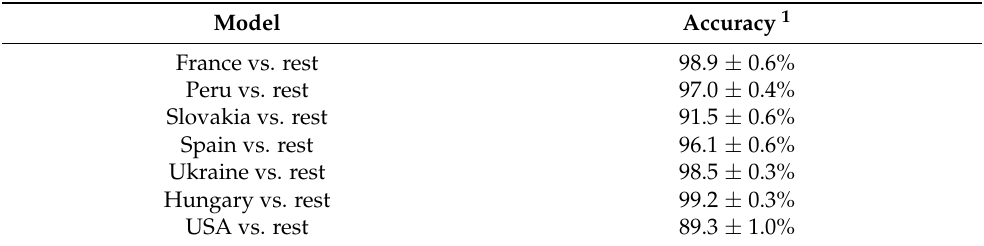
Table 1. Classification results of two class RF models (one country vs. rest, 100 repeated 10-fold CV) using only the 20 identified marker substances, after pareto scaling as preprocessing.